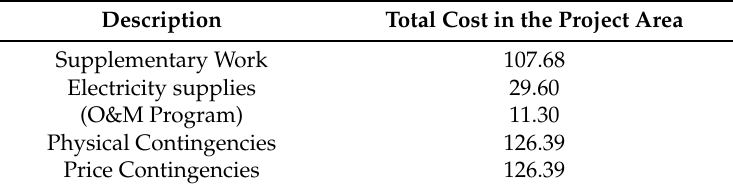
Table 3. Costs in Game c A2,1 .